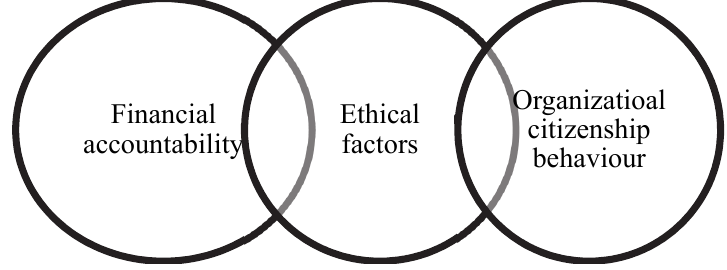
Fig. 1. A National Economic System’s Input-Output Linkages of Fragility/Stability